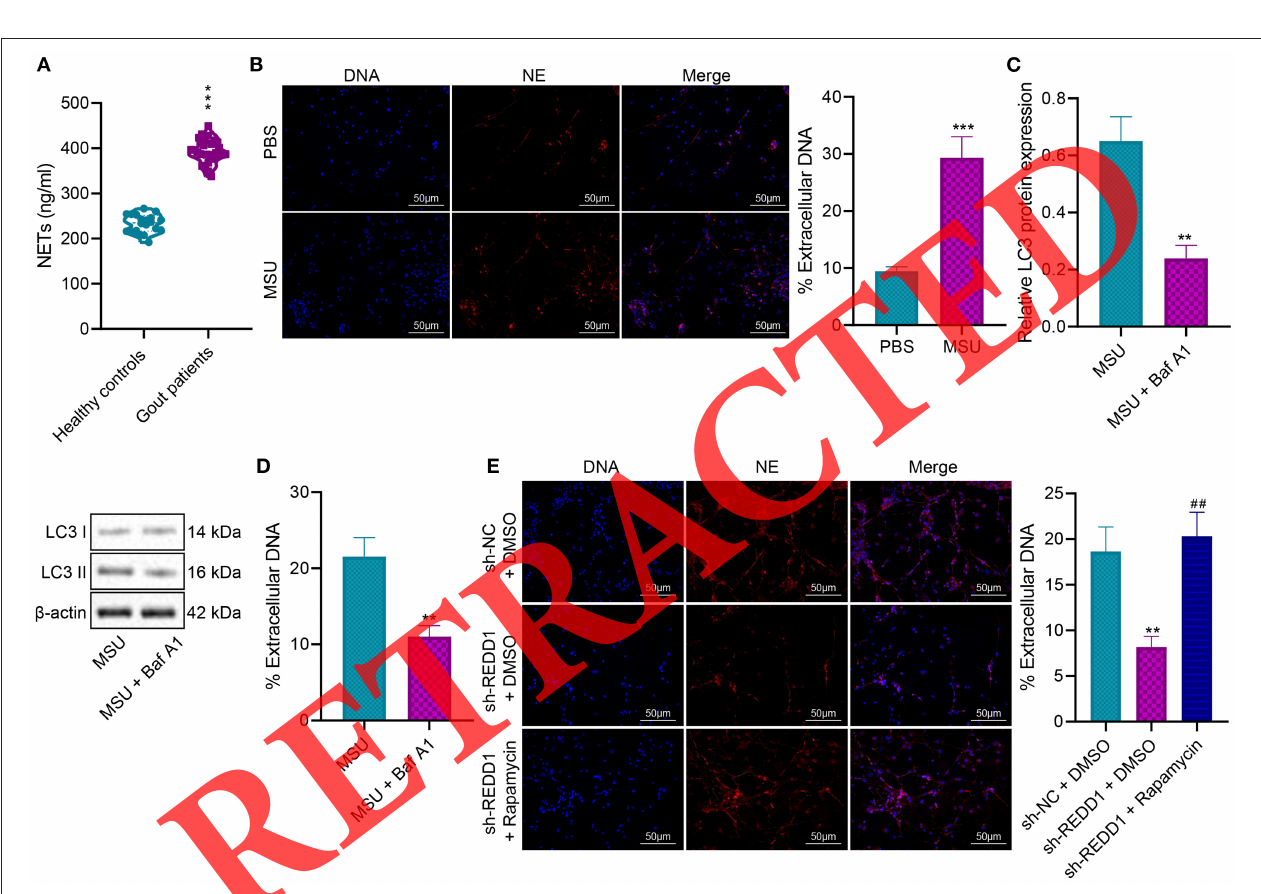
FIGURE 4 | REDD1 induces the formation of NETs by promoting neutrophil autophagy. (A) Levels of NETs in the peripheral blood of 28 gout patients and 20 healthy controls measured by ELISA. *** p < 0.001, compared to healthy controls. (B) Immunofluorescence staining analysis of the formation of NETs in MSU-treated neutrophils, scale bar = 50 µ m. Neutrophil elastase (NE) and DAPI (DNA) were used to stain the cells. The white arrow represents the formed NETs. *** p < 0.001, compared to PBS-treated neutrophils. (C) Western blot analysis of LC3 II protein in MSU-induced neutrophils treated with Baf A1. ** p < 0.001, compared to MSU-treated neutrophils. (D) Immunofluorescence staining analysis of the formation of NETs in MSU-induced neutrophils treated with Baf A1. ** p < 0.01, compared to MSU-treated neutrophils. (E) Immunofluorescence staining analysis of the formation of NETs in neutrophils treated with sh-REDD1 or combined with Rapamycin, scale bar = 50 µ m. ** p < 0.01, compared to neutrophils treated with sh-NC and DMSO. ## p < 0.01, compared to neutrophils treated with sh-REDD1 and DMSO. Data are shown as mean ± standard deviation of three technical replicates. Data between two groups were compared using unpaired t -test while those among multiple groups were assessed by one-way